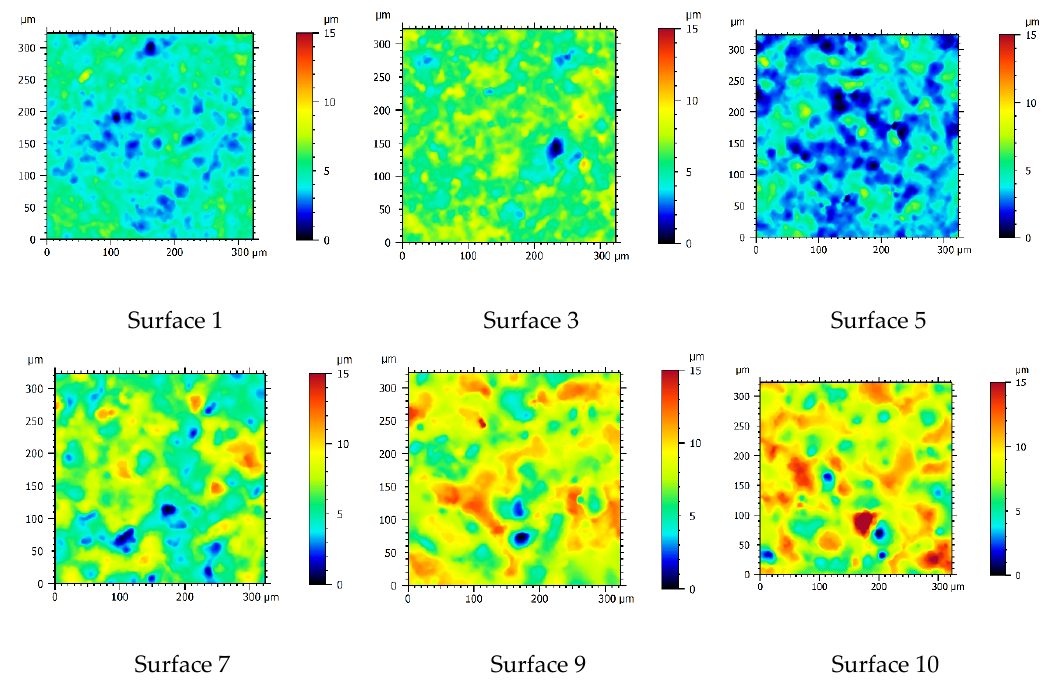
Figure 4. Six out of ten representatives of measured surfaces randomly chosen after dataset preparation step. Renderings of other surfaces are available in Supplementary Materials (Figure S1).